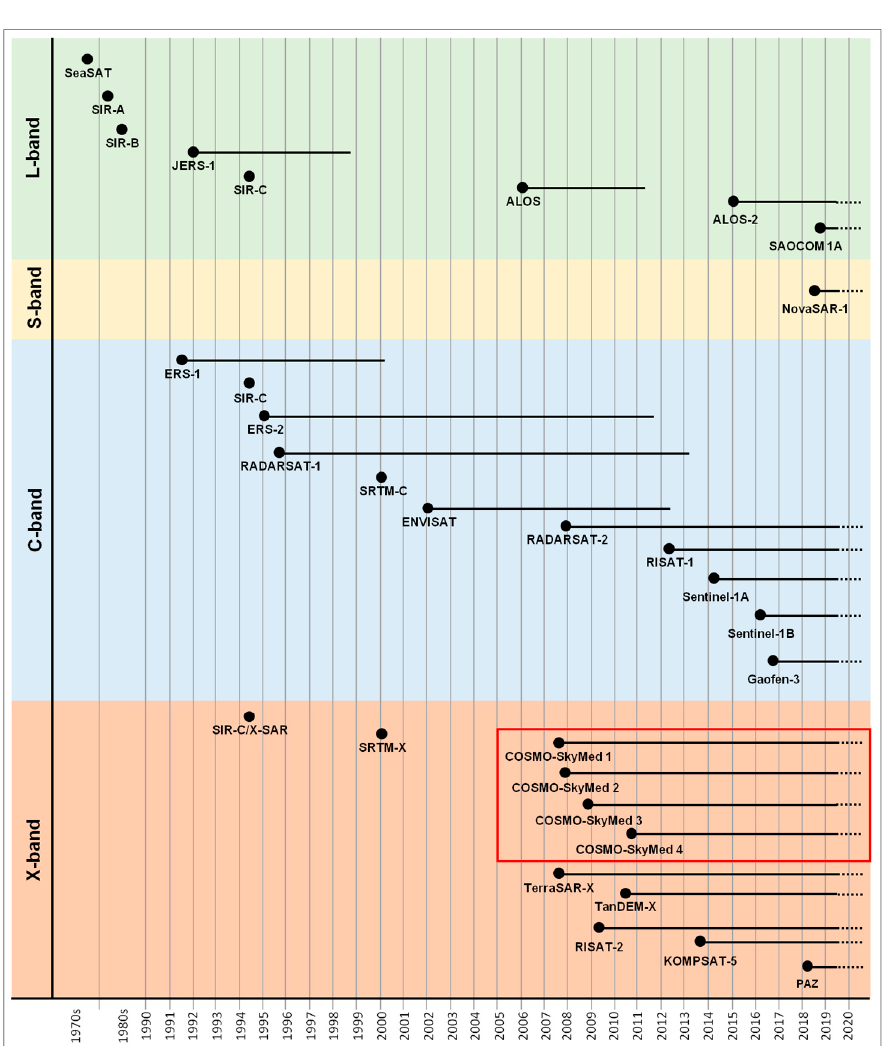
Figure 1. COnstellation of small Satellites for Mediterranean basin Observation (COSMO-SkyMed) in the context of past and current satellite synthetic aperture radar (SAR) systems distinguished by radar band as of 2019.